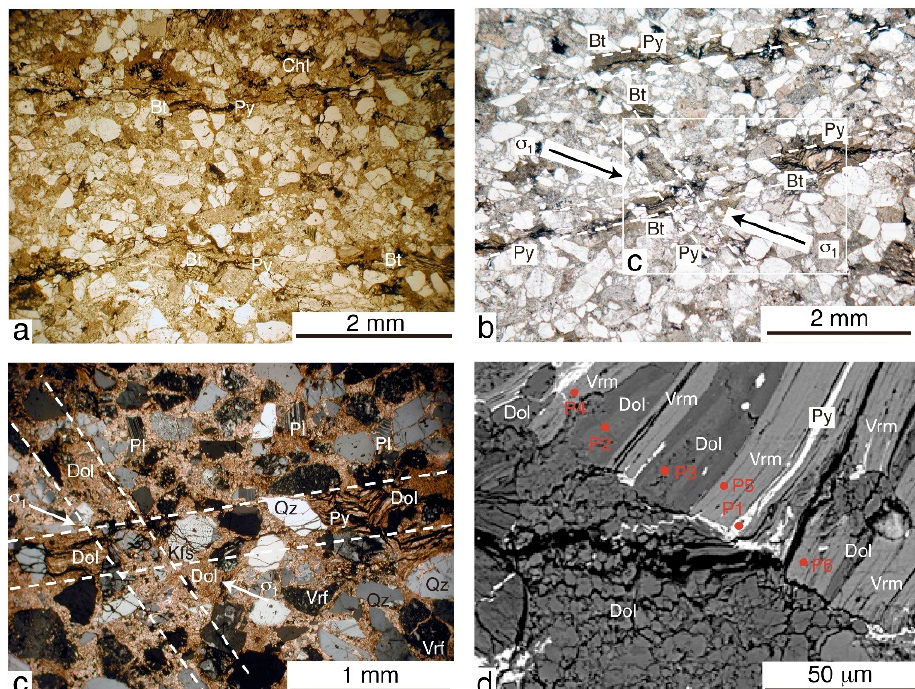
Figure 7. Microphotographs of deformation bands in outcrop sample KT2. See Figures 1b and 2b for the locality. ( a ) Phyllosilicate bands (plane-polarized light). Note that extended biotite grains aligned nearly parallel to the bedding plane forming deformation bands, and pyrite intruded along the bands. ( b ) Conjugate cataclasitic bands (plane-polarized light). Note that pyrite intruded along the deformation bands. The maximum principal stress ( σ 1 ) orientation is shown by arrows. ( c ) Enlargement of the part enclosed by a white frame shown in ( b ) (cross-polarized light). Note that dolomite in the matrix intruded along the cleavage plane in biotite grains. Deformation bands (DBs) and host areas (H) are divided by white dashed lines in ( b , c ). The longer dimension of the microphotograph ( a – c ) is parallel to the bedding plane. ( d ) SEM-BSE microphotograph of an altered biotite grain along deformation bands. Measurements points for microchemical analysis with SEM-EDS and EPMA are indicated by filled red circles. See Table 3 for the compositions. Qz, quartz; Pl, plagioclase; Kfs, K-feldspar; Bt, biotite; Dol, dolomite; Vrm, vermiculite; Kln, kaolinite.